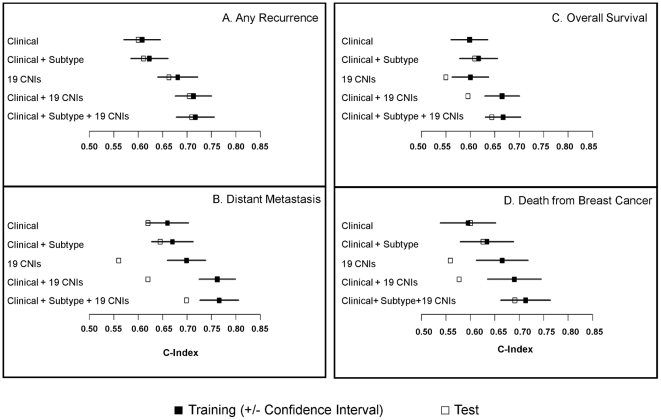
The performance of the clinical, 19-CNI, combined (clinical + tumor subtype) and full (19-CNIs, clinical, tumor subtype) prognostic models by Concordance Index: (A) recurrence, (B) distant metastasis, (C) overall survival, and (D) death from breast cancer.Concordance indices of prognostic models for the various outcomes are shown for the training and test set. The closed square indicates the training set with the 95% confidence interval for the estimate, and the open square represents performance in the test set.